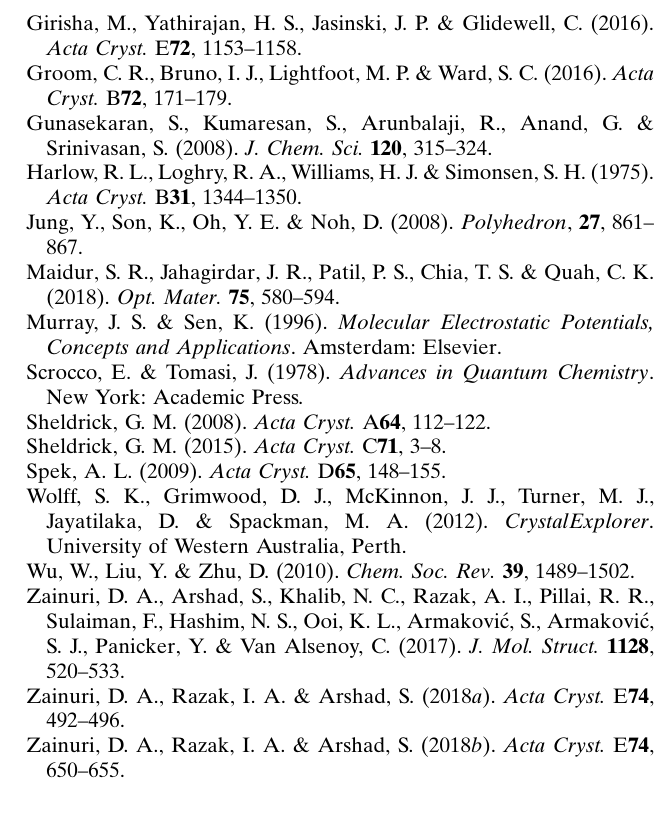
Crystal data collection and structure refinement details are summarized in Table 3. All H atoms were positioned geome- trically [C—H = 0.93 and 0.97 A˚ (in (I)) and 0.93 A˚ (in (II))] and refined using riding model with U